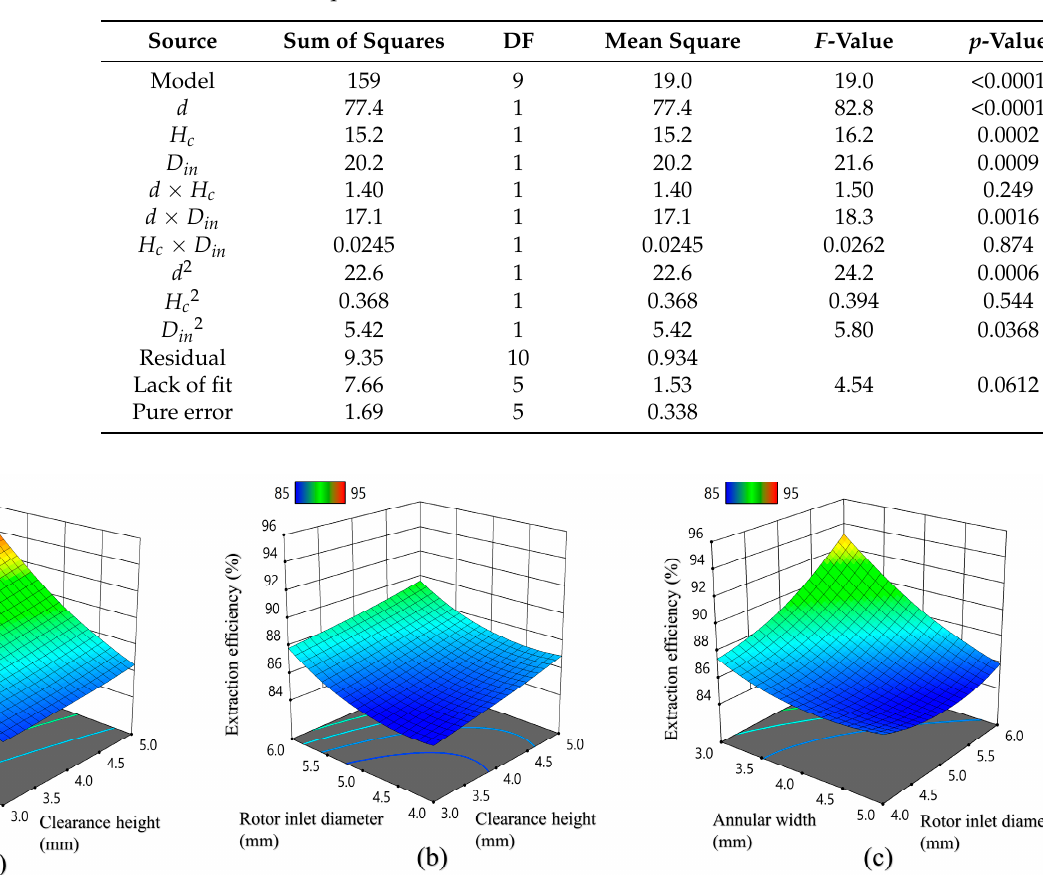
Table 2. ANOVA for Equation (5).